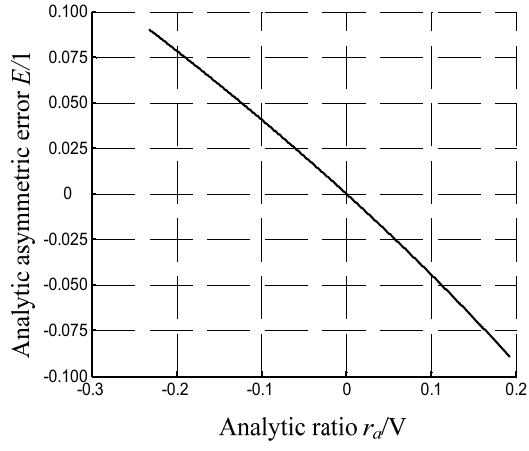
Figure 8. Asymmetric error vs. ratio in analytical relationship.